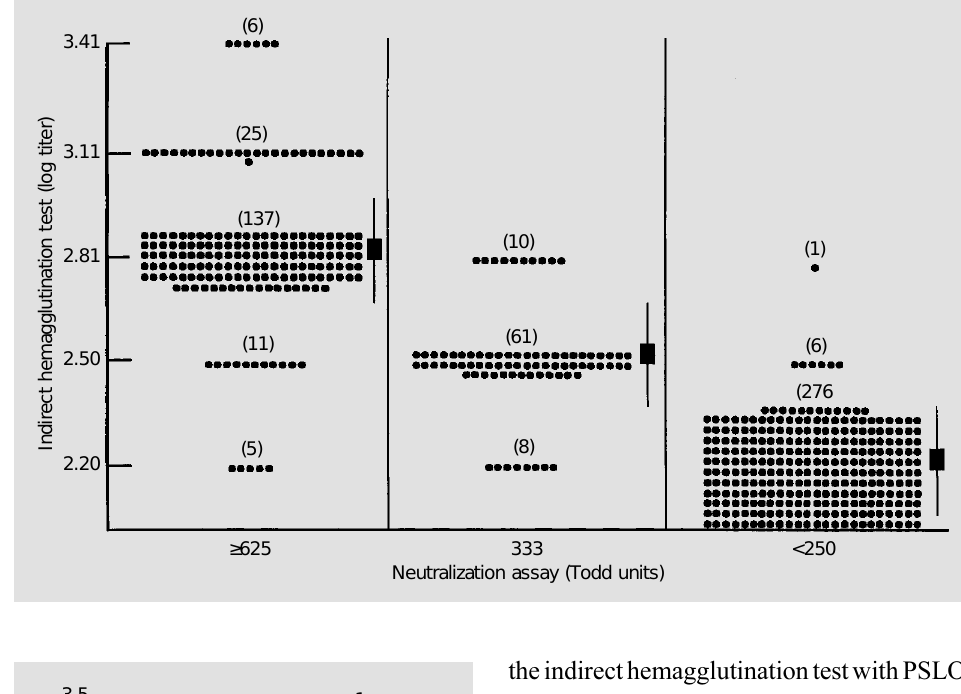
Figure 2 - Relationship between antibodies detected by the indi- rect hemagglutination test and by the neutralization assay (r s =